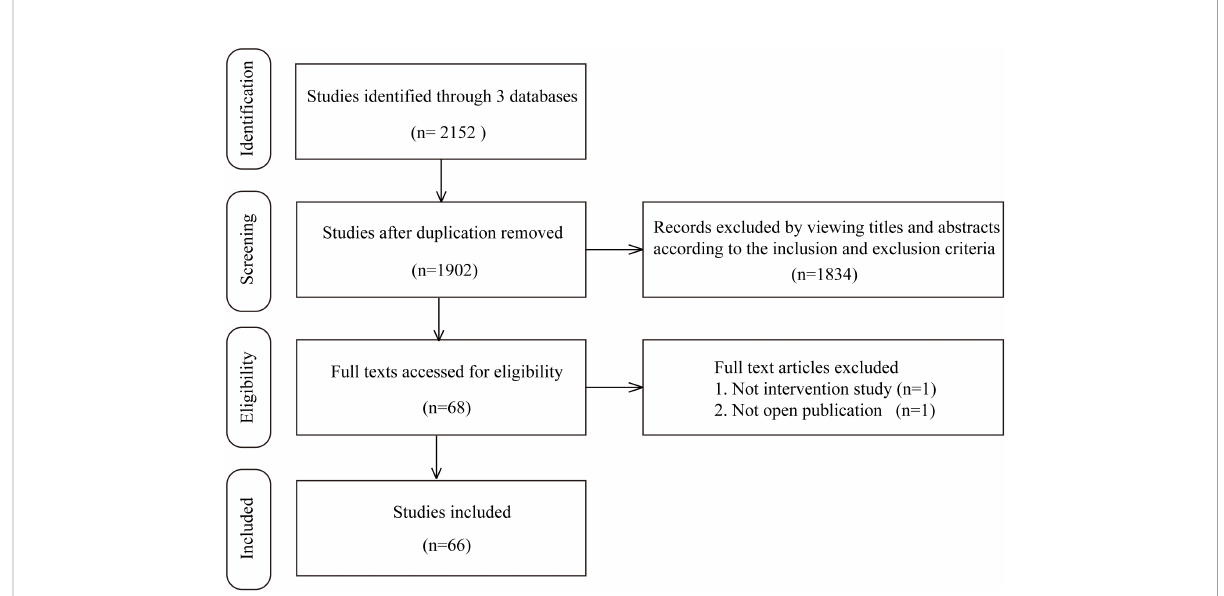
FIGURE 1 The procedures of the searching and selecting of studies included in this